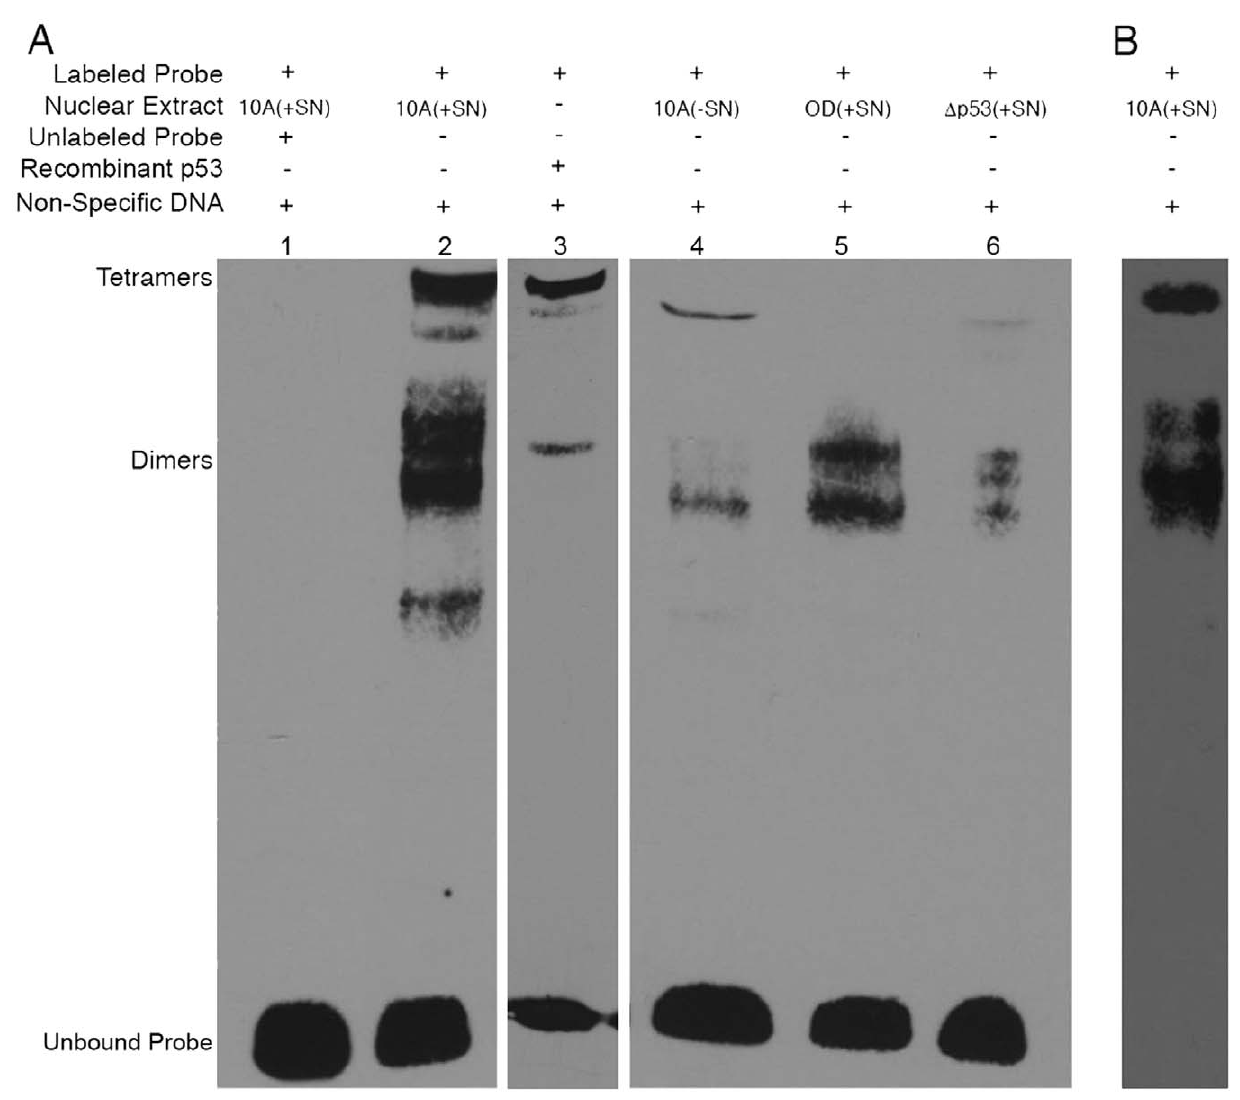
Figure 6. Analysis of p53 binding to head-to-tail response element in cyclin B promoter using electrophoretic mobility shift assays. A , MCF10A, MCF10A/OD, and MCF10A/ D p53 cell lines were incubated with 10 ng/ml SN38 for 24 hours ( + SN) or were left untreated (–SN). Binding reactions were prepared by incubating nuclear extracts or recombinant p53 with a biotin-labeled probe corresponding to the head-to-tail response element in the cyclin B promoter, in the presence ( + ) or absence ( 2 ) of a 200-fold molar excess of specific DNA (unlabeled probe). All binding reactions were carried out in the presence of a 100-fold molar excess of unlabeled non-specific DNA. Complexes were separated on 4% native polyacrylamide gel electrophoresis, transferred to positively charged nylon membrane, and visualized using a streptavidin-horse radish peroxidase conjugate. B , A parallel gel was transferred to nitrocellulose membrane and immunoblotted with p53-specific antibodies.